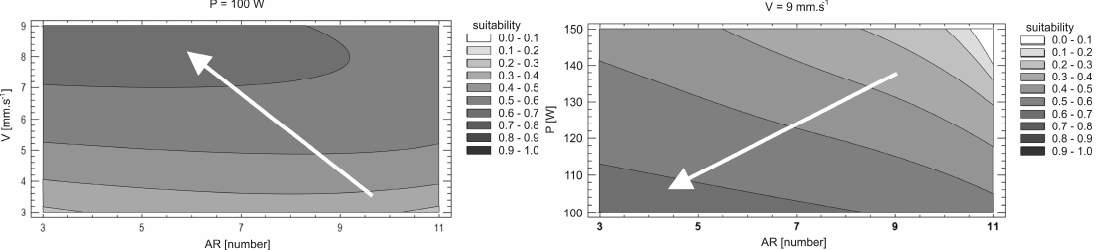
Figure 4. Response areas for joint optimization in the case of fixed power P = 100 W ( left ) and in the case of fixed cutting speed V = 9 mm · s − 1 ( right ).